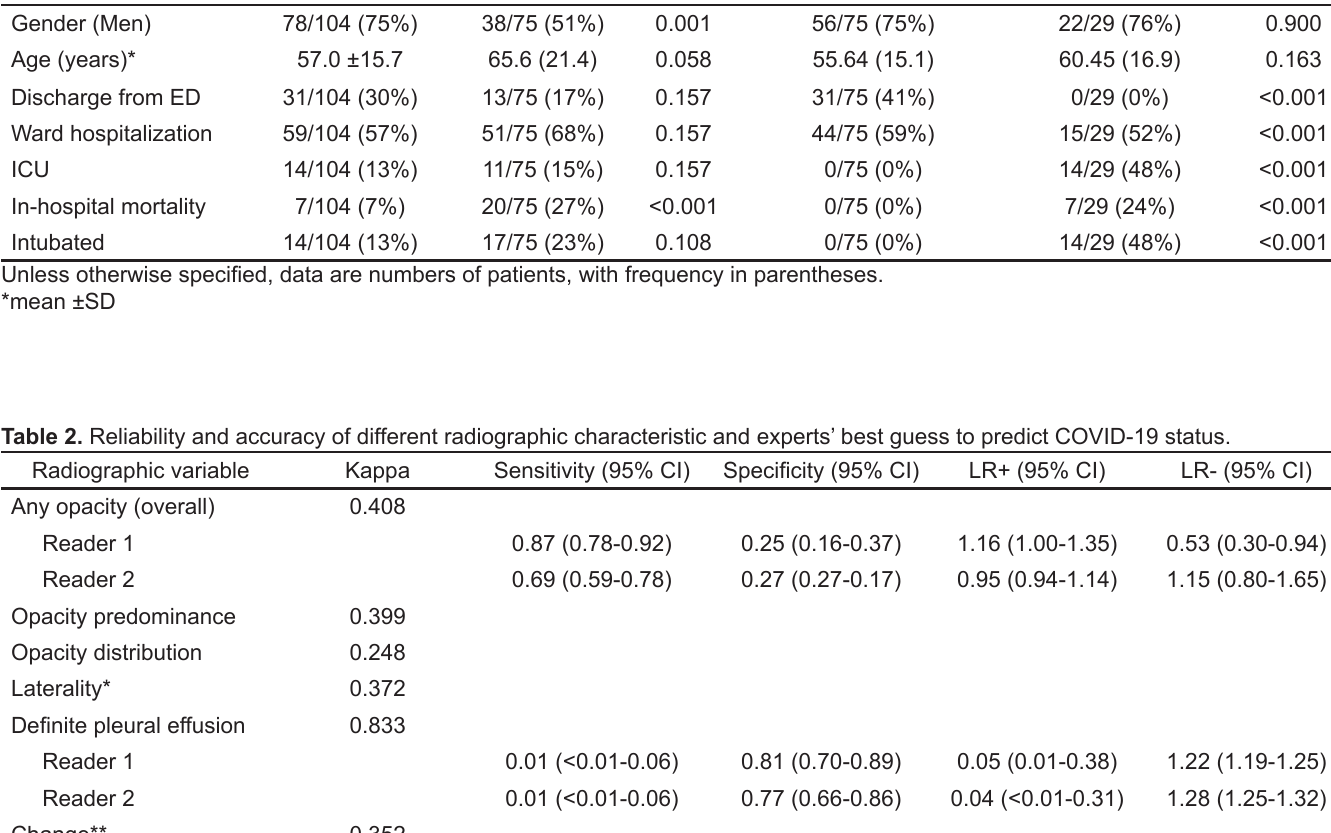
Table 1. Patient characteristics and outcomes with comparison of COVID-19 to control and non-severe to severe COVID-19.